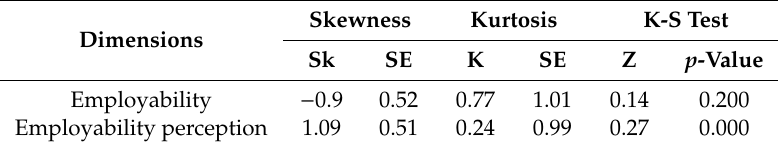
Table 5. Normal distribution tests.